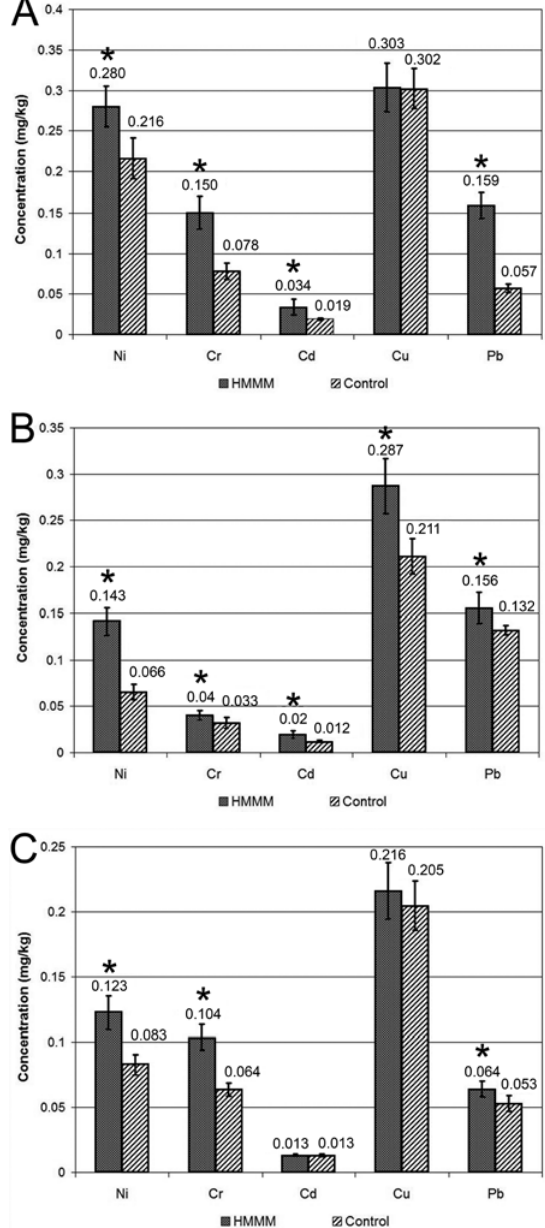
Fig. 1. zinc concentration in body tissues of mixture-exposed Gibel carp (HMMM): muscle (A), gills (B) and liver (C) (Mean±SD). All test values are significantly different from control ( p < 0.05)